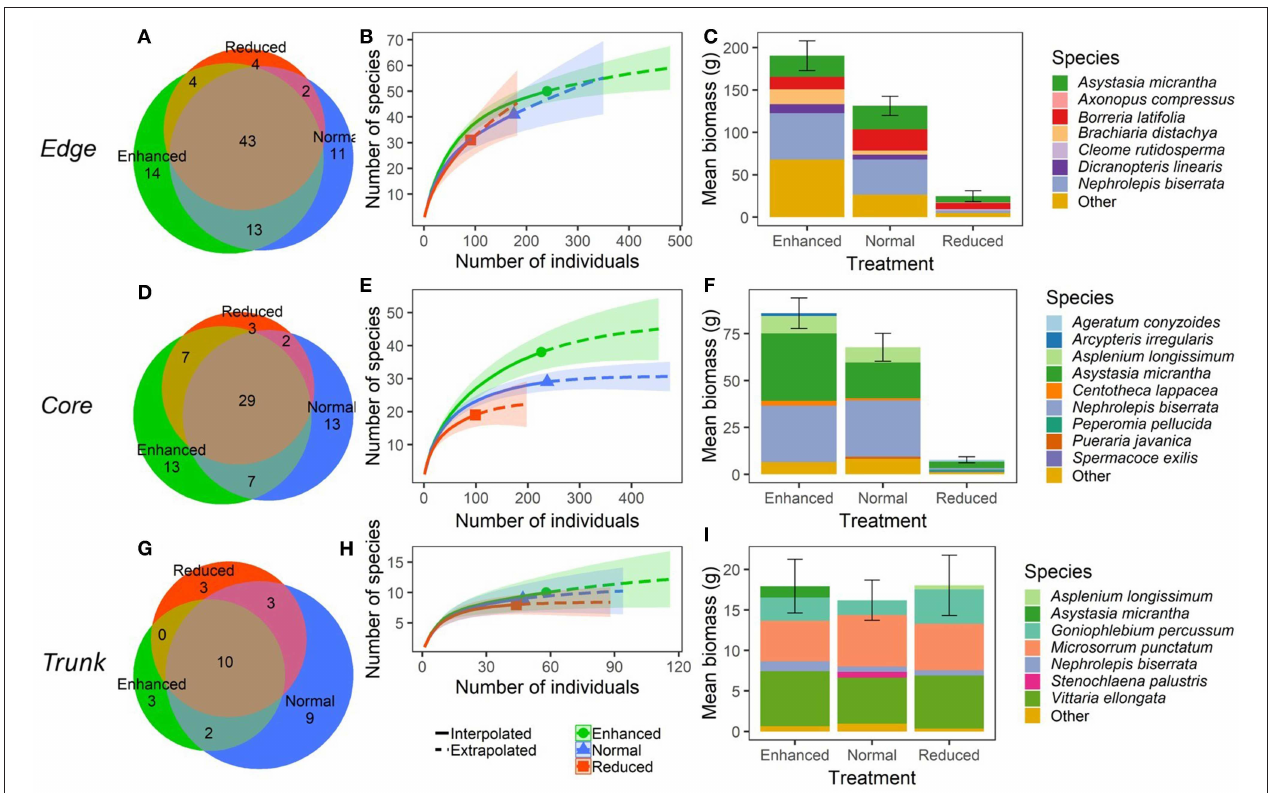
FIGURE 4 | Plant community composition within different microhabitats (understory at plot edge, “Edge”; understory at plot core, “Core”; and oil palm trunk, “Trunk”) within BEFTA Understory Vegetation Project experimental plots during the post-treatment phase of the experiment. During this time, a third of the plots were managed according to business-as-usual vegetation management (Normal vegetation); a third were managed more intensively (Reduced vegetation); and a third were managed less intensively (Enhanced vegetation). Results for Edge microhabitats are shown in (A–C) ; Core microhabitats are shown in (D–F) ; and Trunk are shown in (G–I) . Panels (A,D,G) show the total number of plant species found within, and shared between, different treatments. Note that the collection effort was double in the Core plots compared to Edge and Trunk. Panels (B,E,H) show interpolated and extrapolated species accumulation curves for the different treatments. Note that the scales are different across panels. The legend in (H) also applies to (B) and (E) . Panels (C,F,I) show the relative dominance of different plant species within each treatment in terms of the total mean plant biomass ( ± SE) per 1m 2 quadrat split across the five most dominant (by biomass) plant species, and “Other” plant species. Note that the scales are different across panels. The species name “ Asystasia gangetica subsp. micrantha” has been shortened to Asystasia micrantha within the figure. We have included a colour blind friendly version of this figure in Supplementary Materials